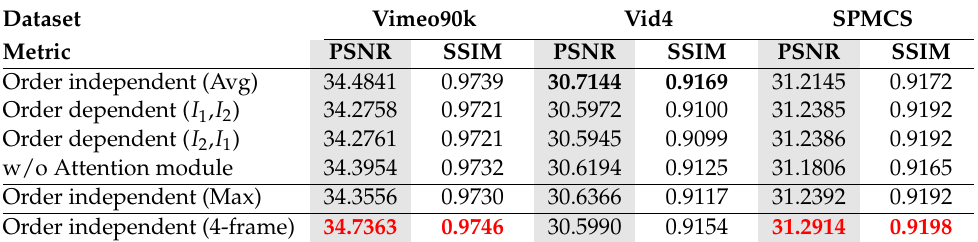
Table 4. Ablation study of our method including the full versions, without the permutation invariance module (in-order and reverse-order inputs), and attention module. The best performing method is indicated in bold. Please note that the number of parameters between the Order independent full method and Order dependent baselines do not differ. Further, with four frames input, the performance increases (denoted in red) as opposed to degradation, showing the effects of permutation invariance. Dataset Vimeo90k Vid4 SPMCS Metric PSNR SSIM PSNR SSIM PSNR